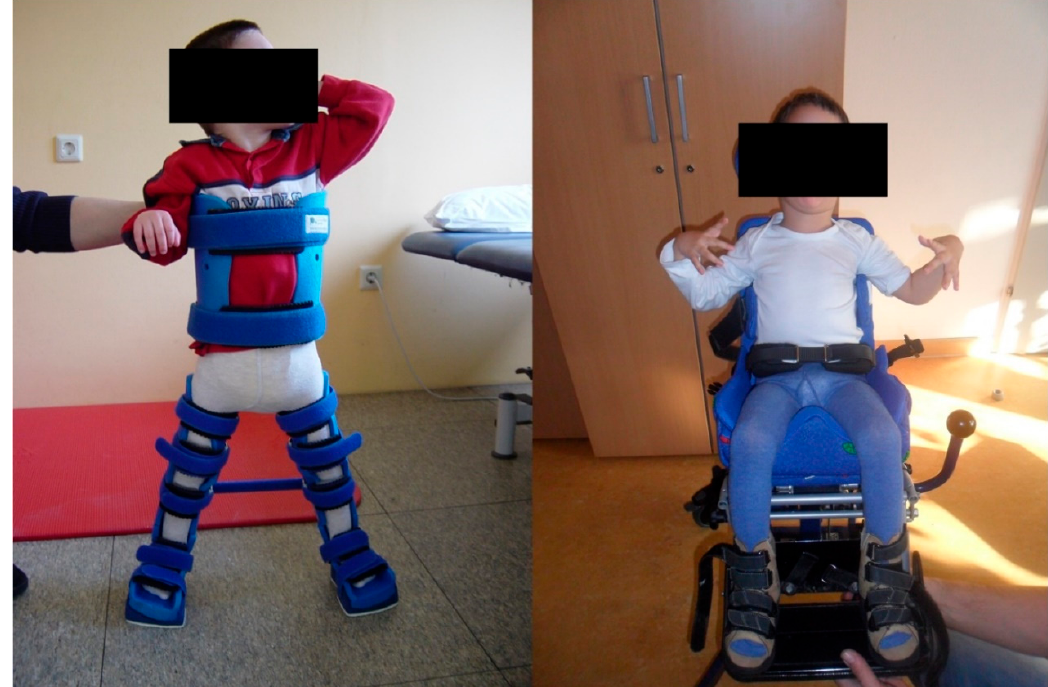
Figure 1. CP patients with a supportive orthosis for the trunk and lower limbs ( left image ) and in a wheel chair with typical upper limb posture ( right image ) are shown.